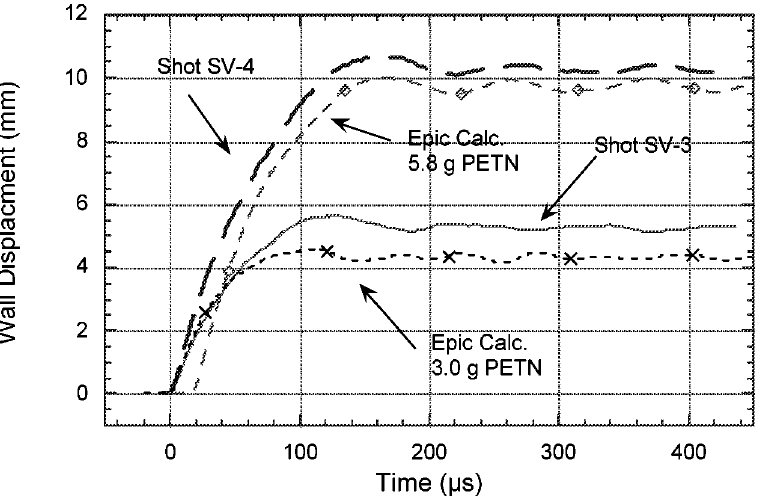
Fig. 6. Comparison of EPIC calculations with dynamic responses from Shots SV-3 and